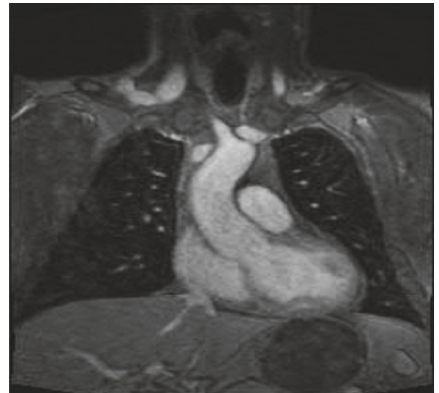
Figure 3: CT angiogram MIP images showing bilateral popliteal aneurysms highlighted by red